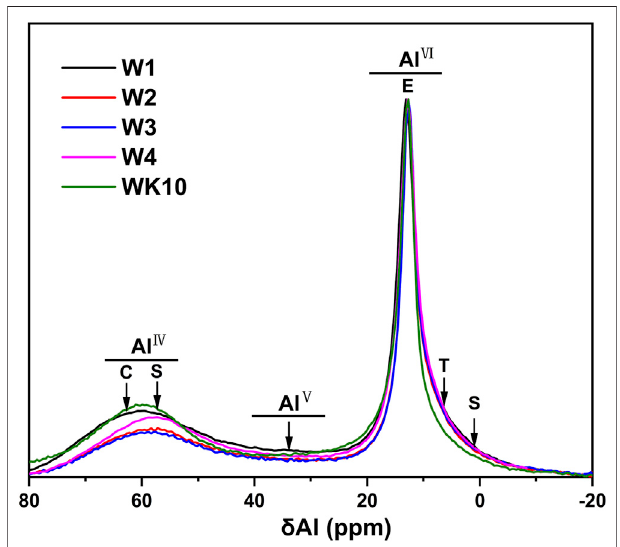
FIGURE 8 | 27 Al NMR spectra of P-SSC binders at 28